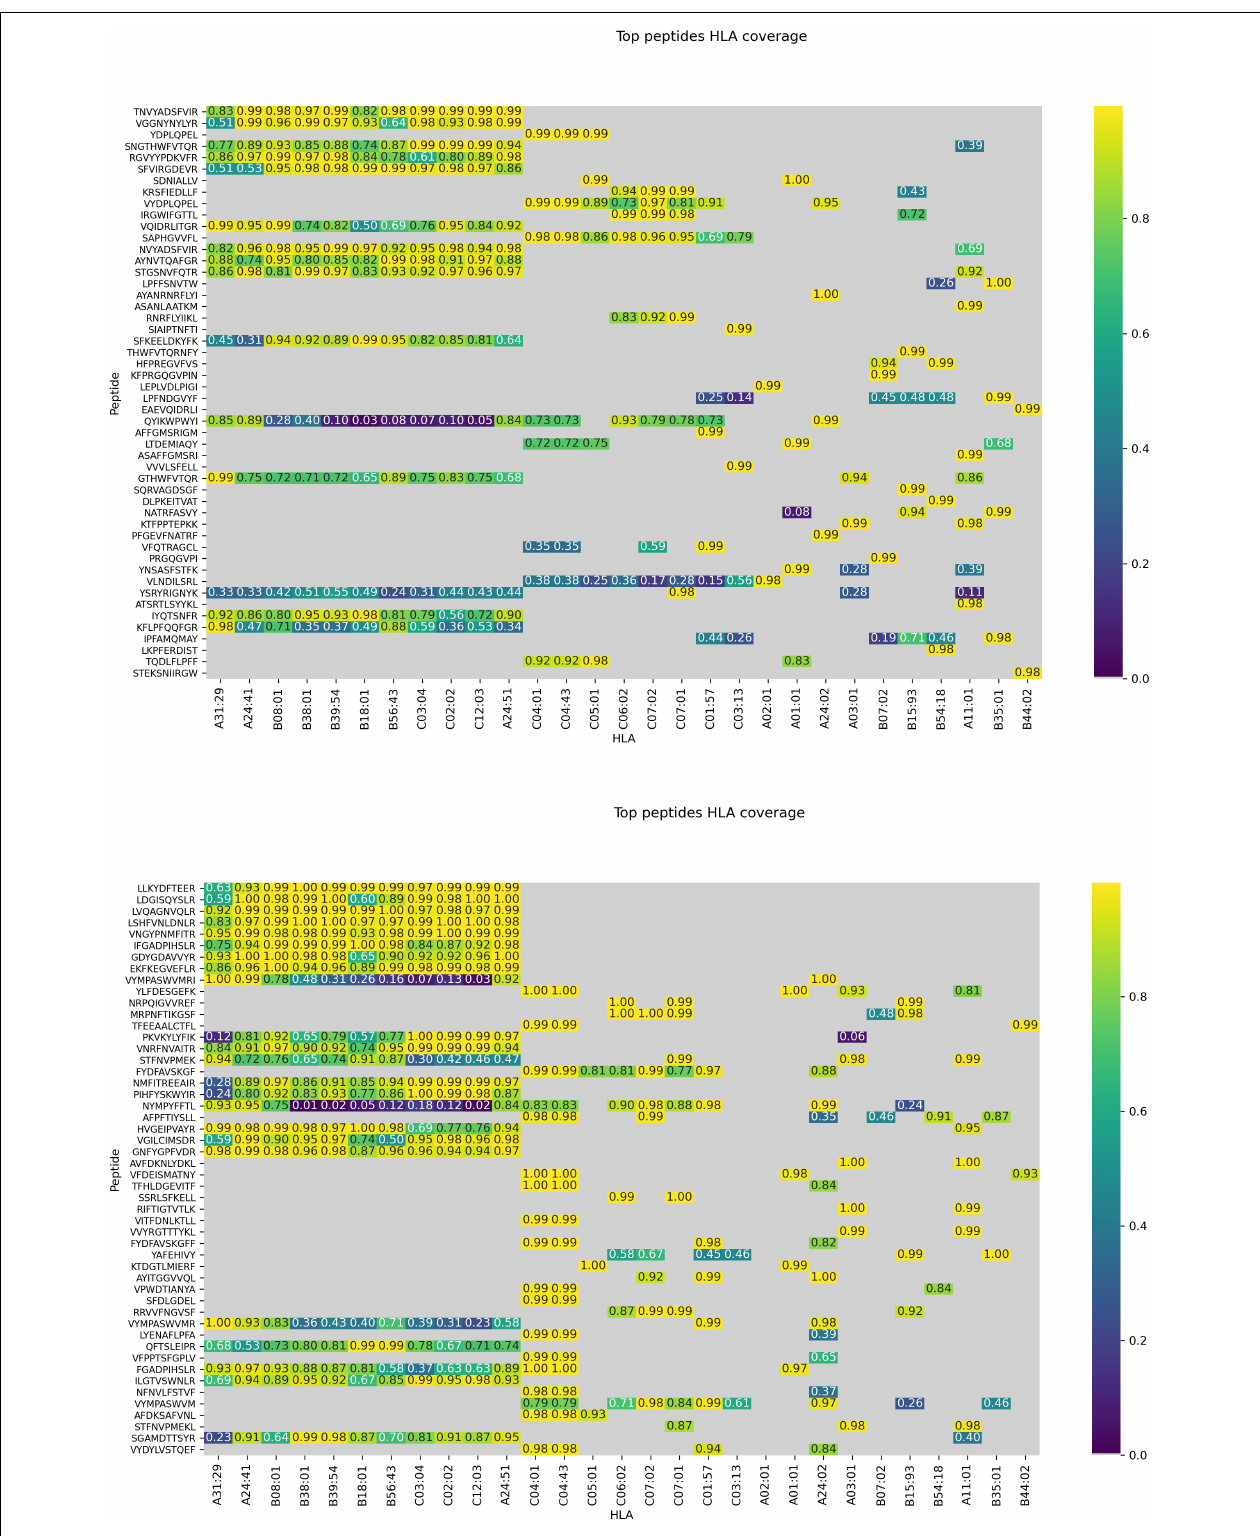
FIGURE 7 | Peptides presented across multiple HLAs. Immunogenicity scores are reported for epitopes from both structural (top) and non-structural (bottom) proteins. Peptide-HLA combinations marked in gray are predicted non-binders (netMHCpan 4.0 percentile rank > 2). For the remaining pHLAs, the color relates to the percentile rank of our predictions for a given HLA type (0.95 means that the prediction is among top 5% of the predictions for that particular HLA allele).